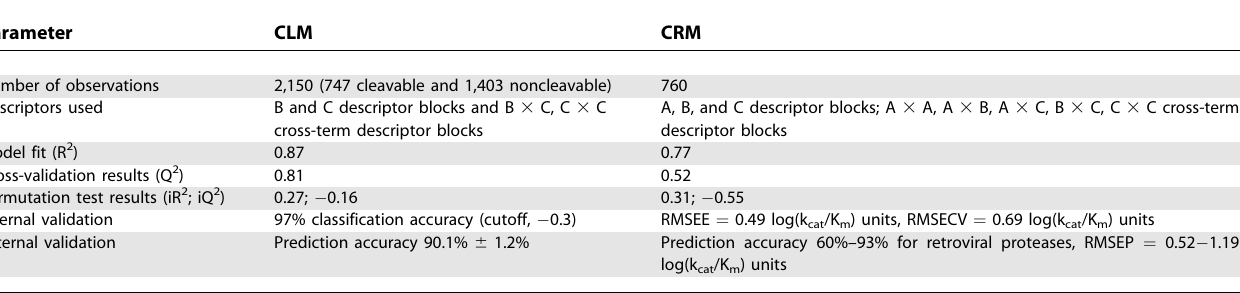
Table 2. Details of the CLM and CRM Obtained Herein, and Their Validation Results Parameter CLM